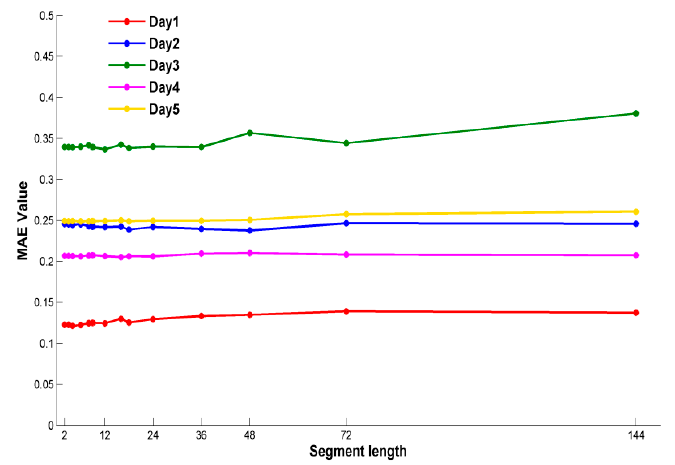
Figure 4. Mean Absolute Error (MAE) comparison of dynamic time warping time series strategy (DTWS)- improved support degree (ISD) at different segment length in five days.